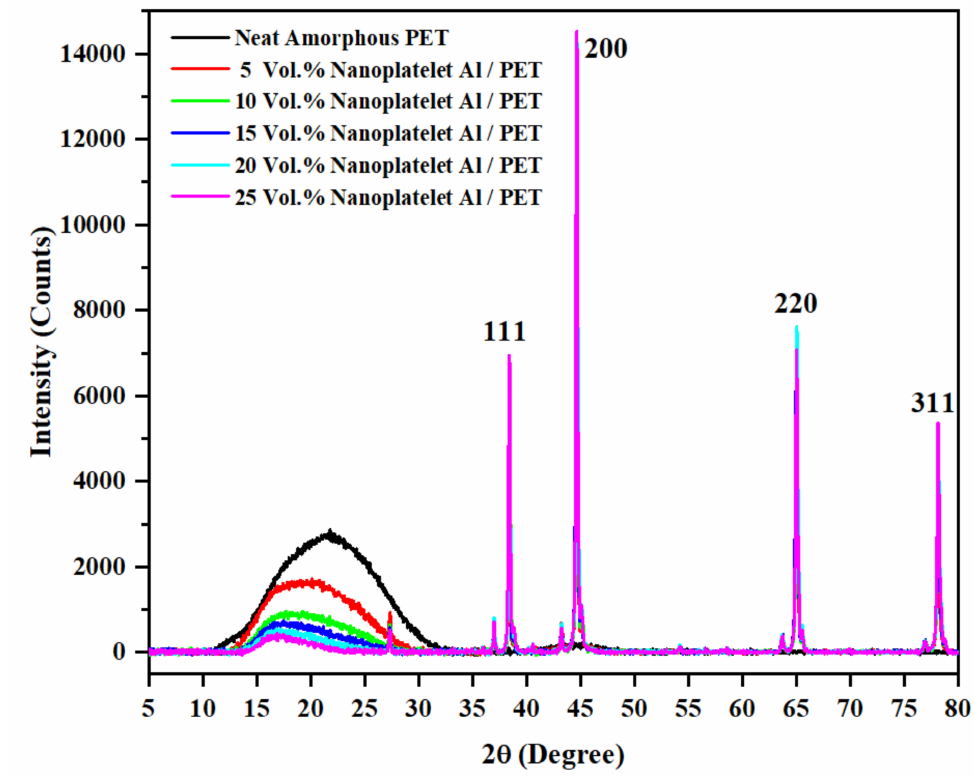
Figure 4. Wide-angle X-ray diffractogram of the nano platelet Al–PET composites. The broad peak at 2 θ values between 11 ◦ and 33 ◦ confirms that the PET is in an amorphous state in the bars. The tall sharp peaks are from Al and the Miller indices are indicated. The small sharp peaks at 2 θ ~27 ◦ , 37 ◦ , 44 ◦ , 64 ◦ , and 77 ◦ are